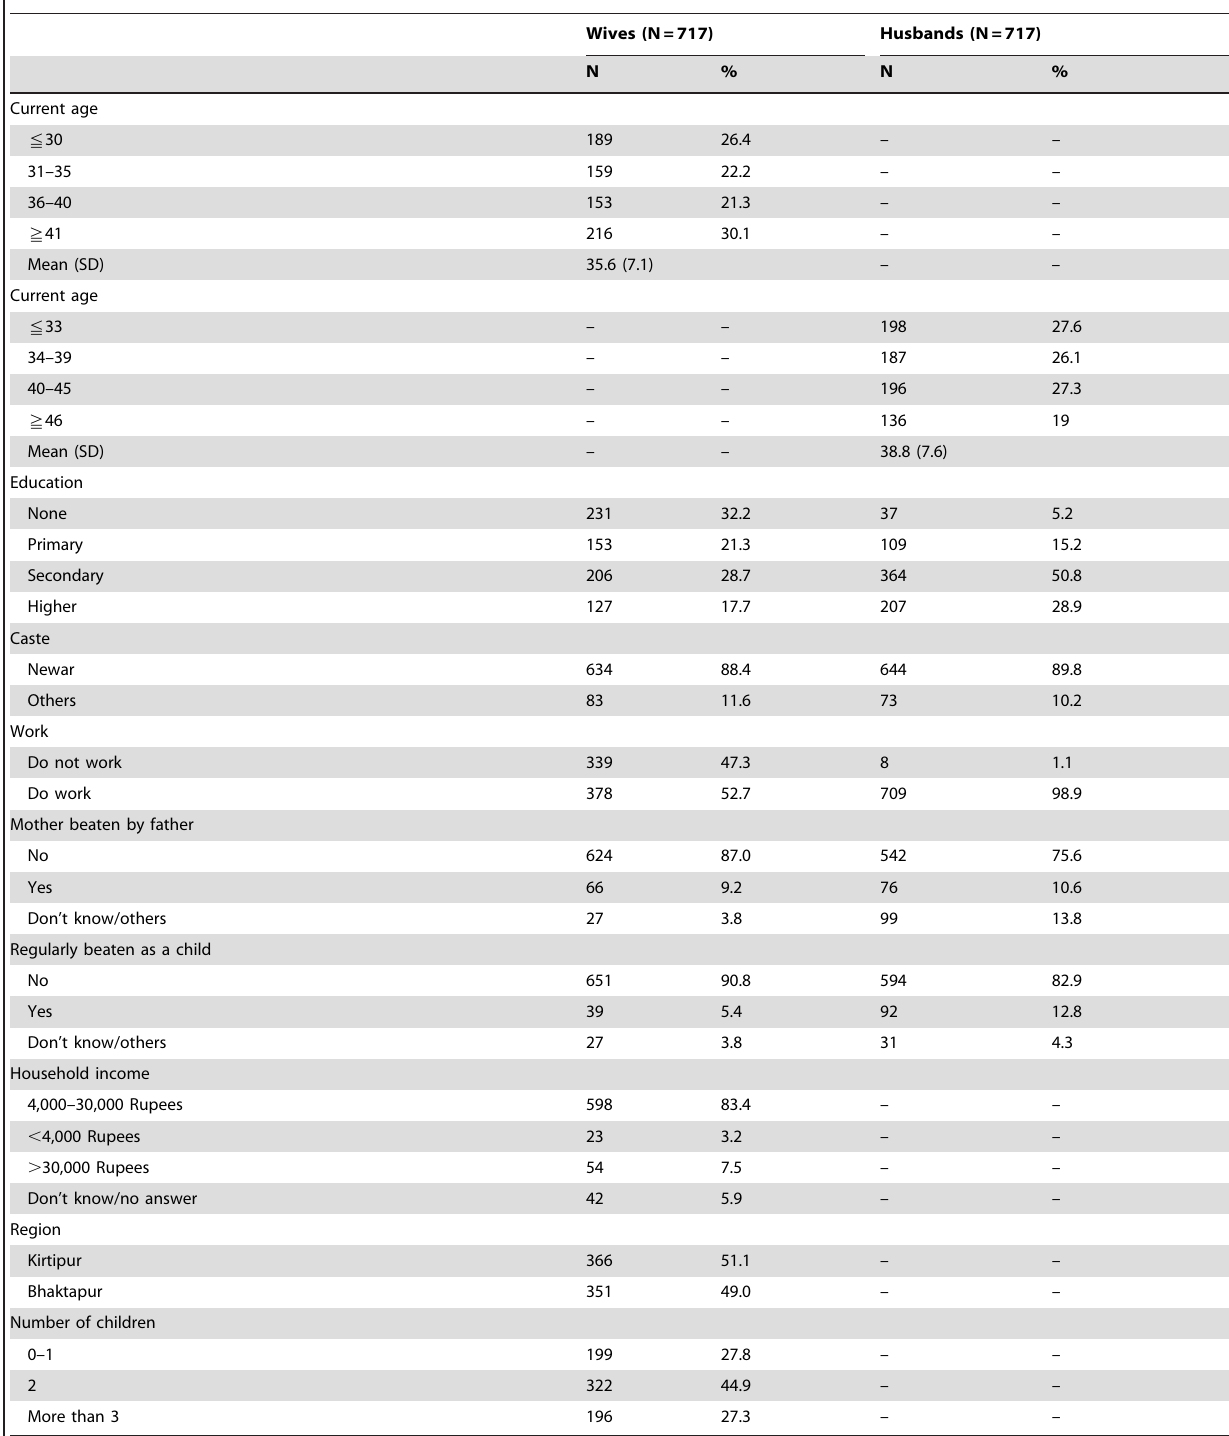
Table 1. Sociodemographic characteristic of Nepalese